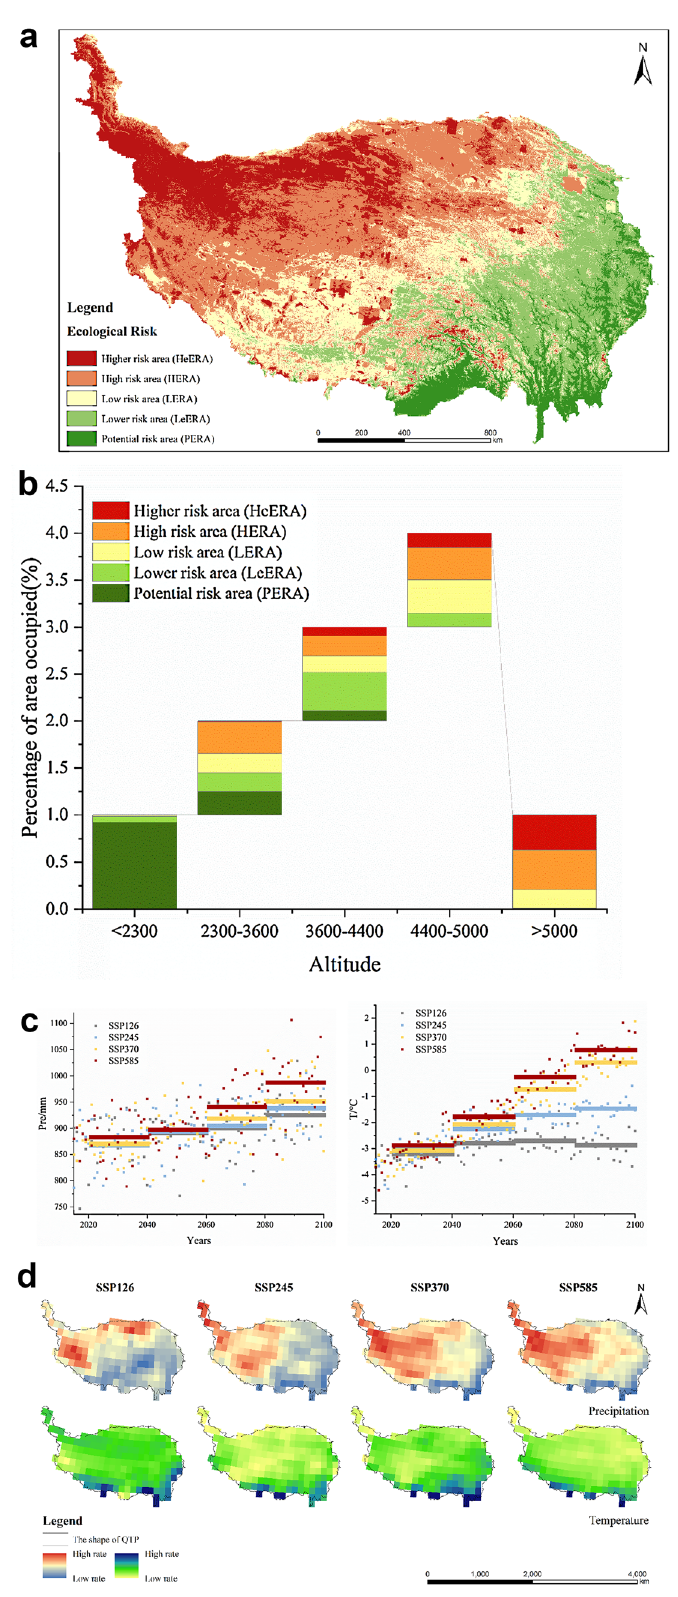
Figure 2. ( a ) The ecological Risk of the QTP (base year). The map was generated by ArcGIS sofware (Version 10.5 for Desktop). ( b ) The proportion of the ecological risk of the QTP at different altitudes (base year). ( c ) Precipitation (mm) ( a ) and average temperature (°C) ( b ) of the QTP under different SSP scenarios from 2021 to 2100. ( d ) The ecological risk of the QTP under different SSP scenarios from 2021 to 2100. The map was generated by ArcGIS sofware (Version 10.5 for Desktop). ( e ) The rate of change of each type of ecological risk from 2021 to 2100. The map was generated by ArcGIS sofware (Version 10.5 for Desktop). ( f ) The rate of change of each type of ecological risk from 2021 to 2100 in different time periods. ( g ) The rate of change of each type of ecological risk from 2021 to 2100 in different